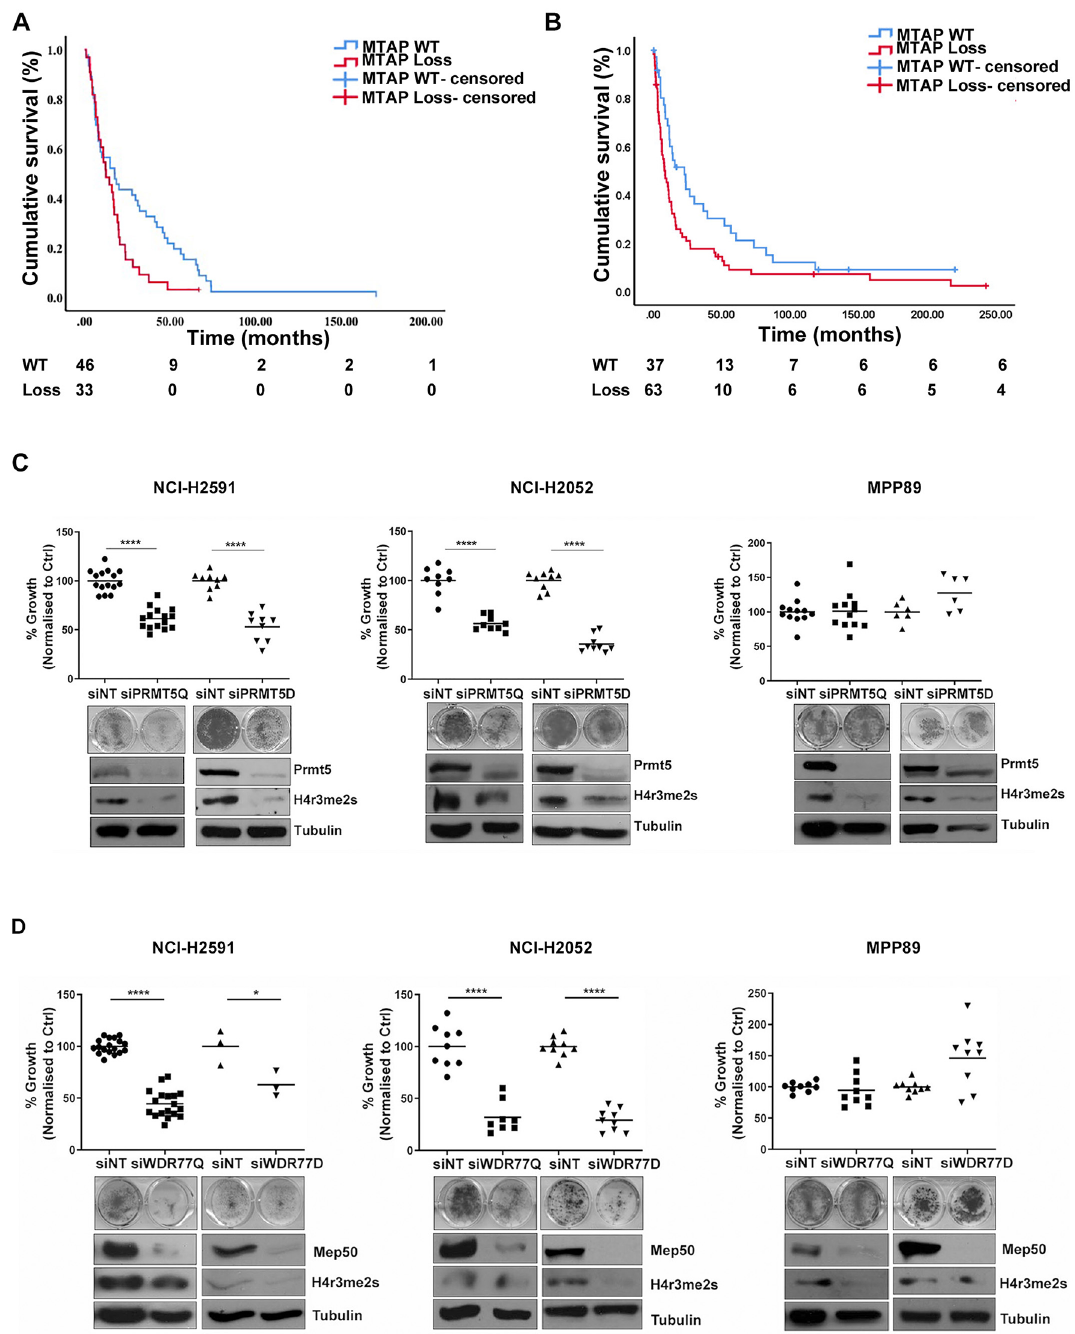
Figure 1. MTAP is negatively prognostic in MPM ( A ) Kaplan–Meier survival curve for OS of MTAP positive and MTAP negative patients (n = 79). ( B ) Kaplan–Meier survival curve for OS of MTAP positive and MTAP negative patients from validation cohort (n = 100). ( C ) MTAP negative cells (NCI-H2052, NCI-H2591) and MTAP positive cells (MPP89) were transfected with siNT or siPRMT5 20 nM (Q: Qiagen sequence, D: Dharmacon sequence). Cell proliferation was measured by clonogenic assay 5–7 days after transfection. Data were normalized to siNT controls (NCI-H2591: Q p = 0.0001 D p = 0.0001; NCI-H2052: Q p = 0.0001 D p = 0.0001; NCI-H2452: Q p = 0.0001 D p = 0.0001; MPP89: Q p = n.s. D p = n.s.). The levels of PRMT5 expression and H4 arginine 3 symmetrical di-methylation (H4R3me2S) were measured by western blot 72 h after transfection. These gels have been cropped and full length gels are presented in Supplementary Fig. 3A–C. (D ) Cells were transfected with siNT or siWDR77 20 nM. Cell proliferation was measured by clonogenic assay 5–7 days after transfection. Data were normalized to siNT controls (NCI-H2591: p = 0.0001; NCI- H2052: p = 0.0001; NCI-H2452: p = n.s; MPP89: p = n.s.). The levels of PRMT5 expression and H4 arginine 3 symmetrical di-methylation (H4R3me2S) were measured by western blot 72 h after transfection. These gels have been cropped and full length gels are presented in Supplementary Fig.